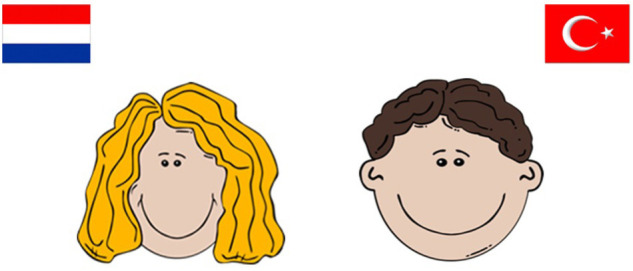
Introduction of cues on language switching task.